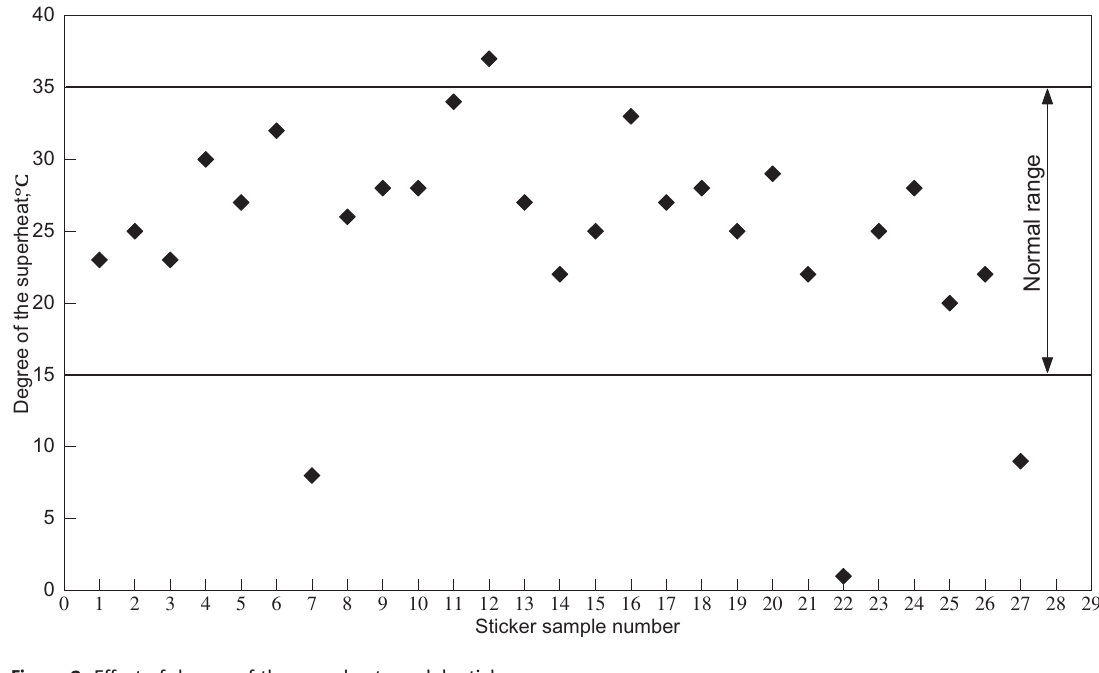
Figure 3: Effect of degree of the superheat on slab sticker.